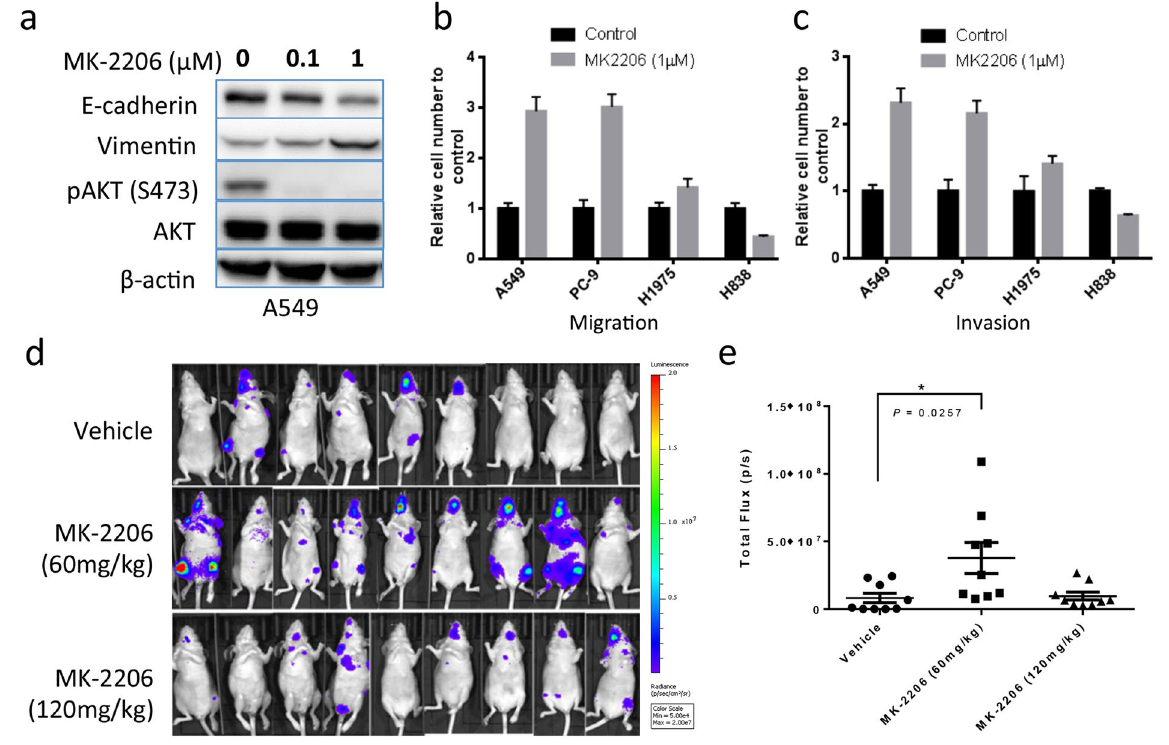
Figure 3. AKT inhibition by MK-2206 promotes invasion and metastasis of NSCLC cells. ( a ) Western blot analyses of E-cadherin, Vimentin, phospho- and total AKT in A549 cells treated with indicated concentration of MK-2206 for 24 hours. ( b ) Migration and ( c ) Invasion of A549, PC-9, H1975 and H838 cells treated with DMSO (Control) or 1 µ M MK-2206. ( d ) Experimental metastases of A549 cells in mice treated with vehicle, 60 mg/kg, or 120 mg/kg of MK-2206, visualized by luciferase bioluminescence imaging at week 4 following injection. The imaging parameters were equivalent for all images. ( e ) Quantification of the bioluminescence intensities. Graph bar represents mean ± SE. * Indicates statistic significance ( P <